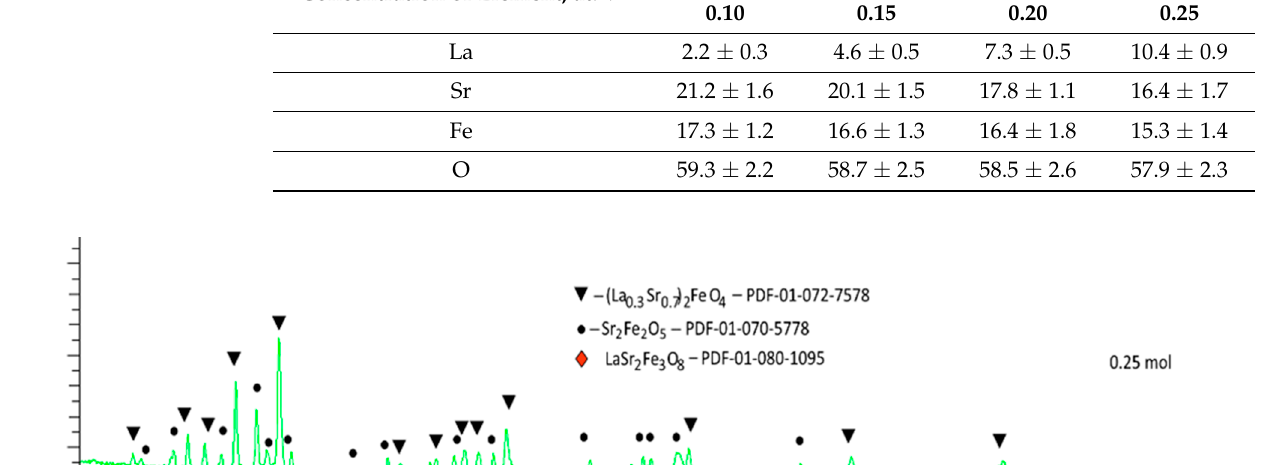
Table 1. Data of energy-dispersive analysis. Concentration of Element, at. %